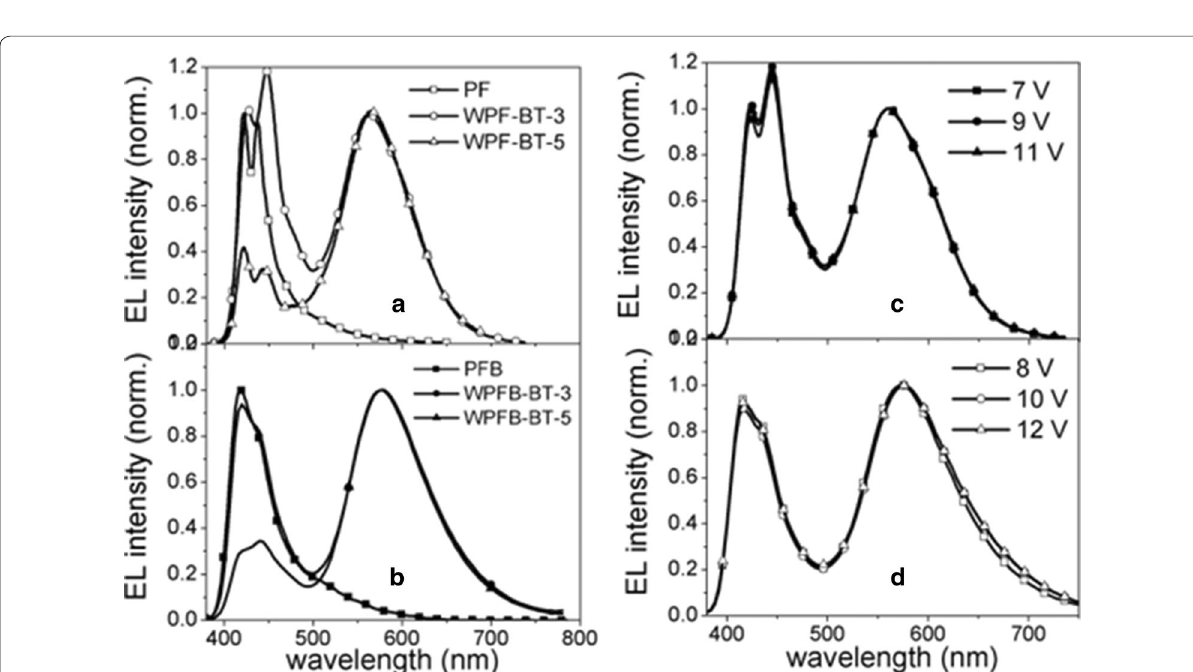
Fig. 12 EL spectra of WPLEDs ( a , b ) and EL spectra of the WPLEDs, c WPFB-BT-3 and d WPF-BT-3 at different driving voltages (Reproduced with permission from Ref. [32] Copyright 2006, ©WILEY–VCH Verlag GmbH &amp; Co. KGaA,